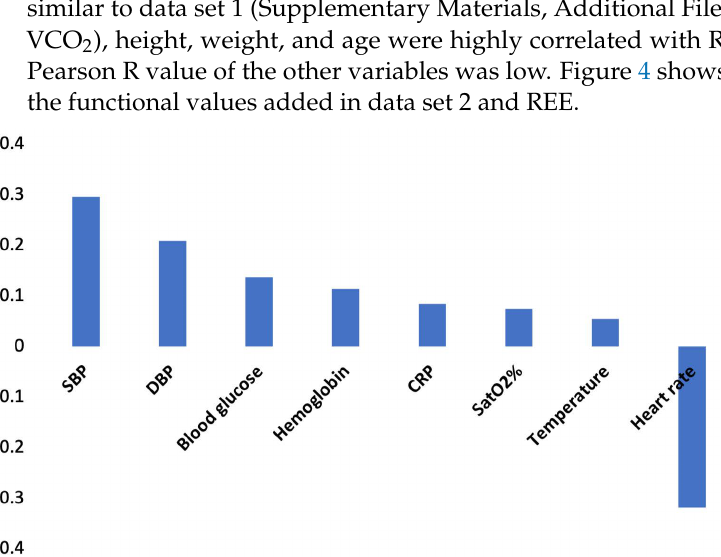
Figure 4. Correlations between the study variables added in Data set 2 and the REE value. Abbreviations: SBP = Systolic Blood Pressure; DBP = Diastolic Blood Pressure; CRP = C-reactive protein; SatO 2 % = Oxygen Saturation